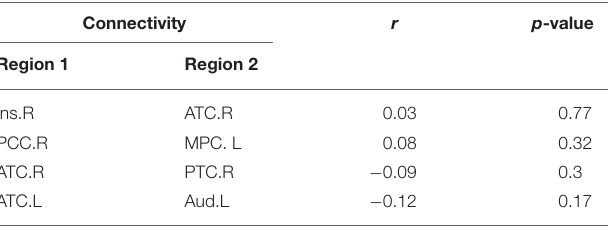
TABLE 2 | Structural connectivity abnormalities in patients at baseline and in remitted patients at follow-up. Connectivity Connectivity strength (Mean ± SD) p -value Region 1 Region 2 BL rFU HC *BL vs. HC *rFU vs. HC 1 rBL vs. rFU Ins.R ATC.R 0.37 ± 0.07 0.36 ± 0.06 0.39 ± 0.07 0.044 0.004 0.105 PCC.R MPC. L 0.51 ± 0.08 0.50 ± 0.07 0.47 ± 0.09 < 0.001 0.023 0.171 ATC.R PTC.R 0.23 ± 0.06 0.24 ± 0.06 ATC.L Aud.L 0.40 ± 0.06 0.42 ± 0.05 0.112